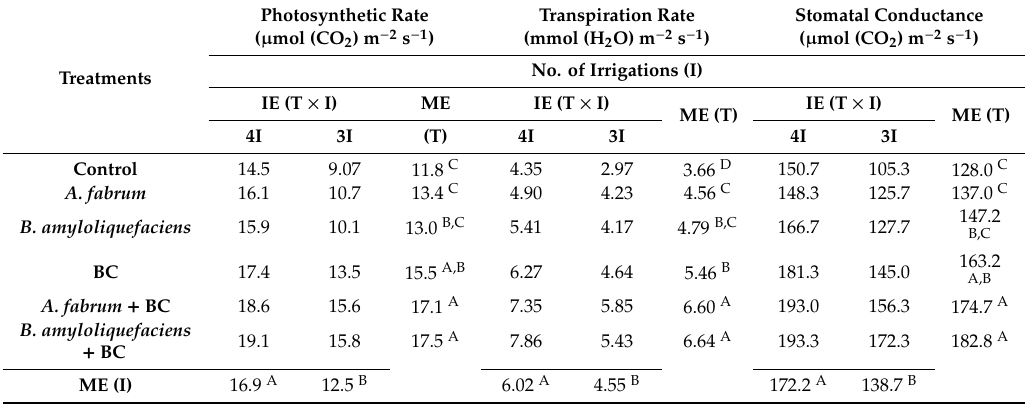
Table 6. E ff ect of Agrobacterium fabrum , Bacillus amyloliquefaciens with / without biochar (30 Mg ha − 1 ) on gas exchange attributes of wheat cultivated in drought-stressed field conditions *.